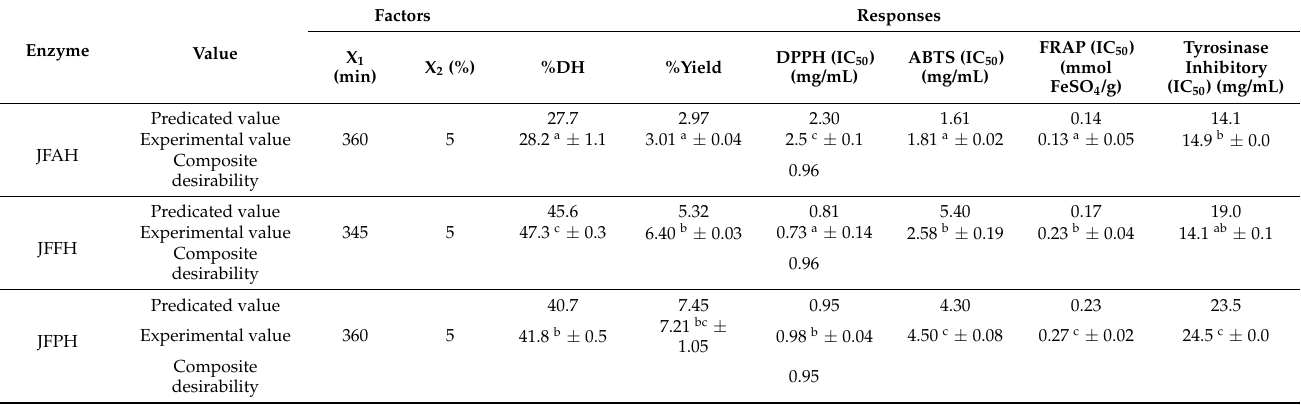
Table 3. Optimized hydrolysis conditions and verification model for all responses of jellyfish hy- drolysate using alcalase (JFAH), flavourzyme (JFFH), and papain (JFPH) hydrolysis.